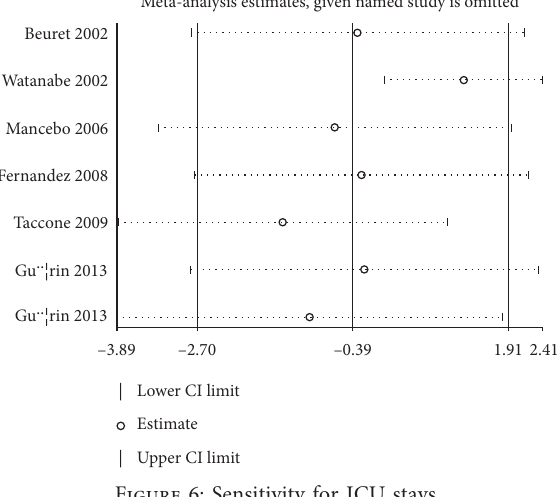
Figure 6: Sensitivity for ICU stays.